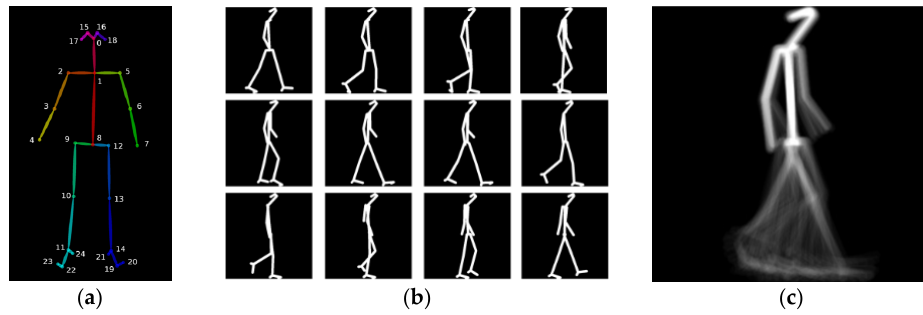
Figure 2. Example of ( a ) output of Open Pose [19], ( b ) skeleton images and ( c ) SEI.